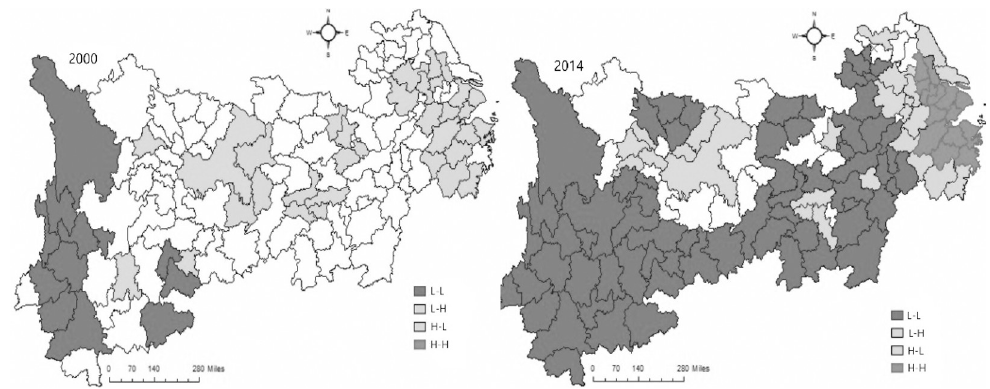
Fig 2. Spatial co-relation of innovation in Yangtze Economic Belt. Data source: Zou Lin, Zhu Yiwen. Research on Innovation Performance in Heterogeneous Region: Evidence from Yangtze Economic Belt in China [J]. Complexity, 2020